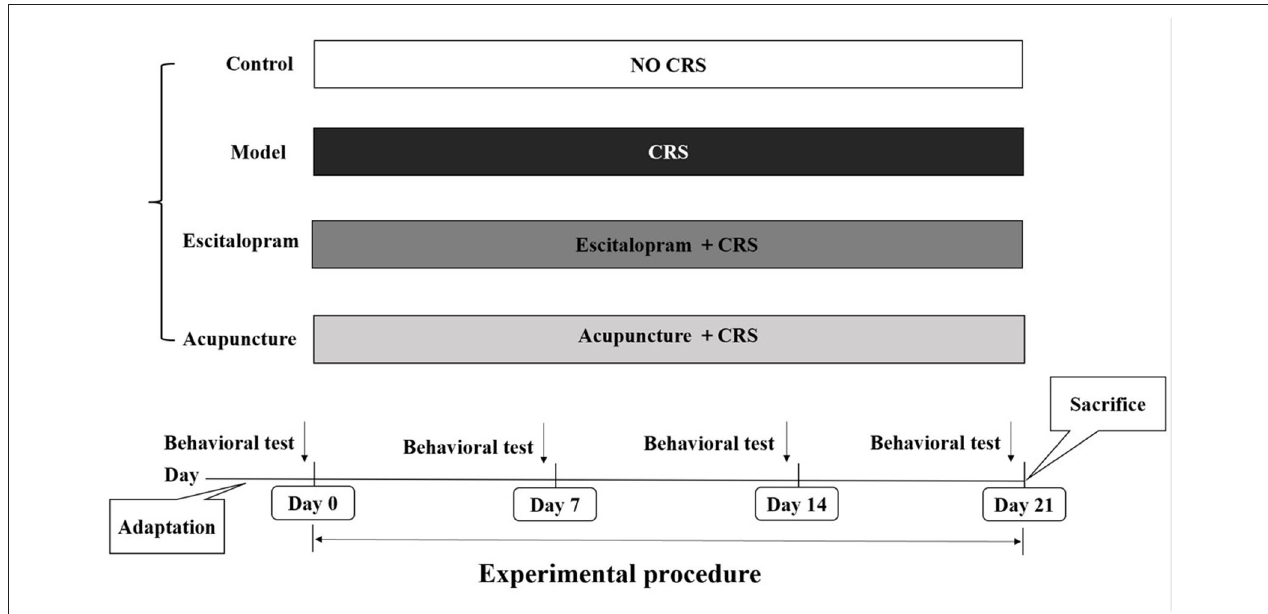
FIGURE 1 | Experimental procedures. CRS, chronic restraint stress; Behavioral tests, including body weight assessment and sucrose preference test.